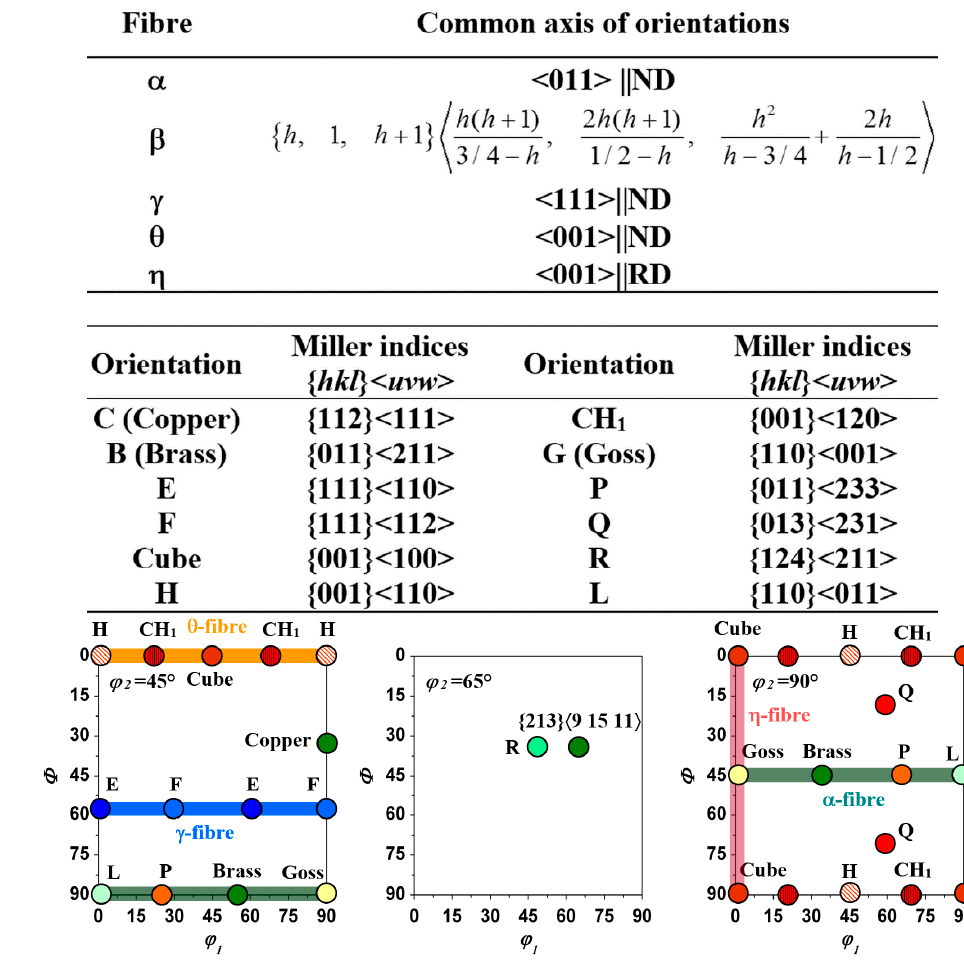
Figure 1. Crystallographic orientations and fibres, which tend to appear during thermomechanical processing of Al alloys and other materials with FCC crystal structure (RD, ND and TD stand for rolling, normal and transverse directions, respectively): ( a ) Miller indices of fibres and orientations; ( b ) φ 2 = 45°, φ 2 = 65°, and φ 2 = 90° sections of Euler space.